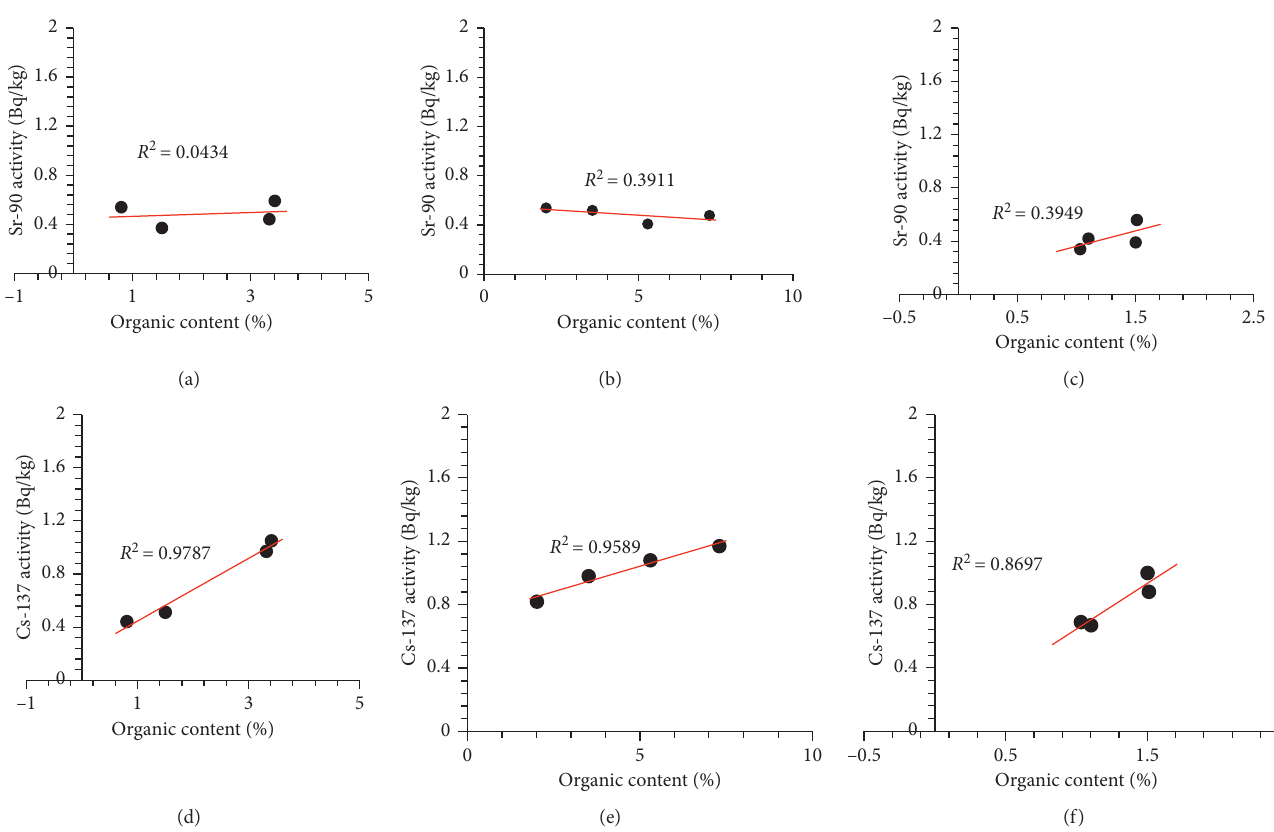
Figure 2: Correlation between organic carbon content and Cs-137 and Sr-90 activity in the sediment. Organic carbon content and Sr-90 activity at (a) Tra Co, (b) Bach Long Vi, and (c) Ky Anh. Organic carbon content and Cs-137 activity at (d) Tra Co, (e) Bach Long Vi, and (f) Ky